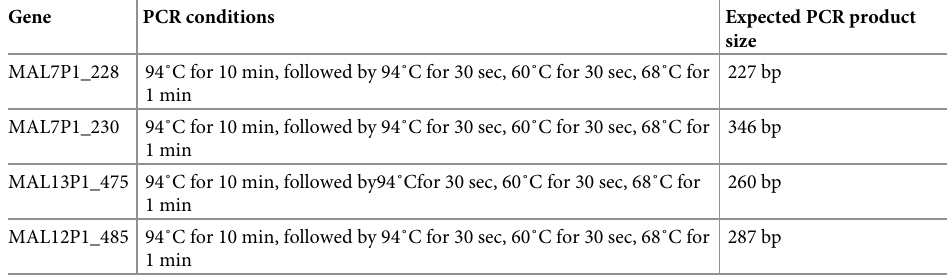
Table 2. PCR conditions and expected product sizes of the pfhrp 2/3 flanking